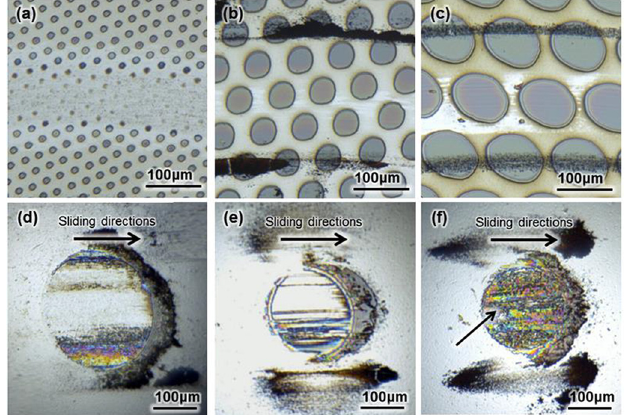
Fig. 6. Optical surface images of wear tracks of micro-textured DLC fi lms with different texture diameters of 10 m m (a), 50 m m (b), and 100 m m (c) as well as the corresponding counterparts of SUJ2 balls (d – f), respectively, after the 30 000 laps of ball-on-disk friction tests.